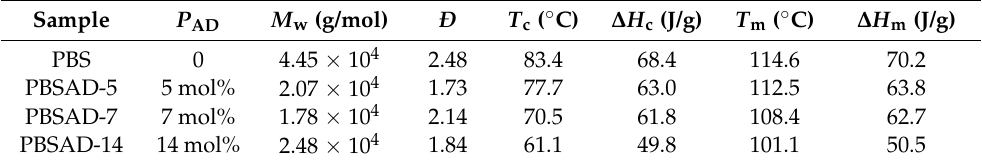
Table 1. Chain compositions, weight–average molecular weights ( M w ), dispersity indices ( Ð ), crystallization temperatures ( T c ) and enthalpy ( ∆ H c ), melting temperatures ( T m ) and enthalpy ( ∆ H m ) of synthesized polyesters.